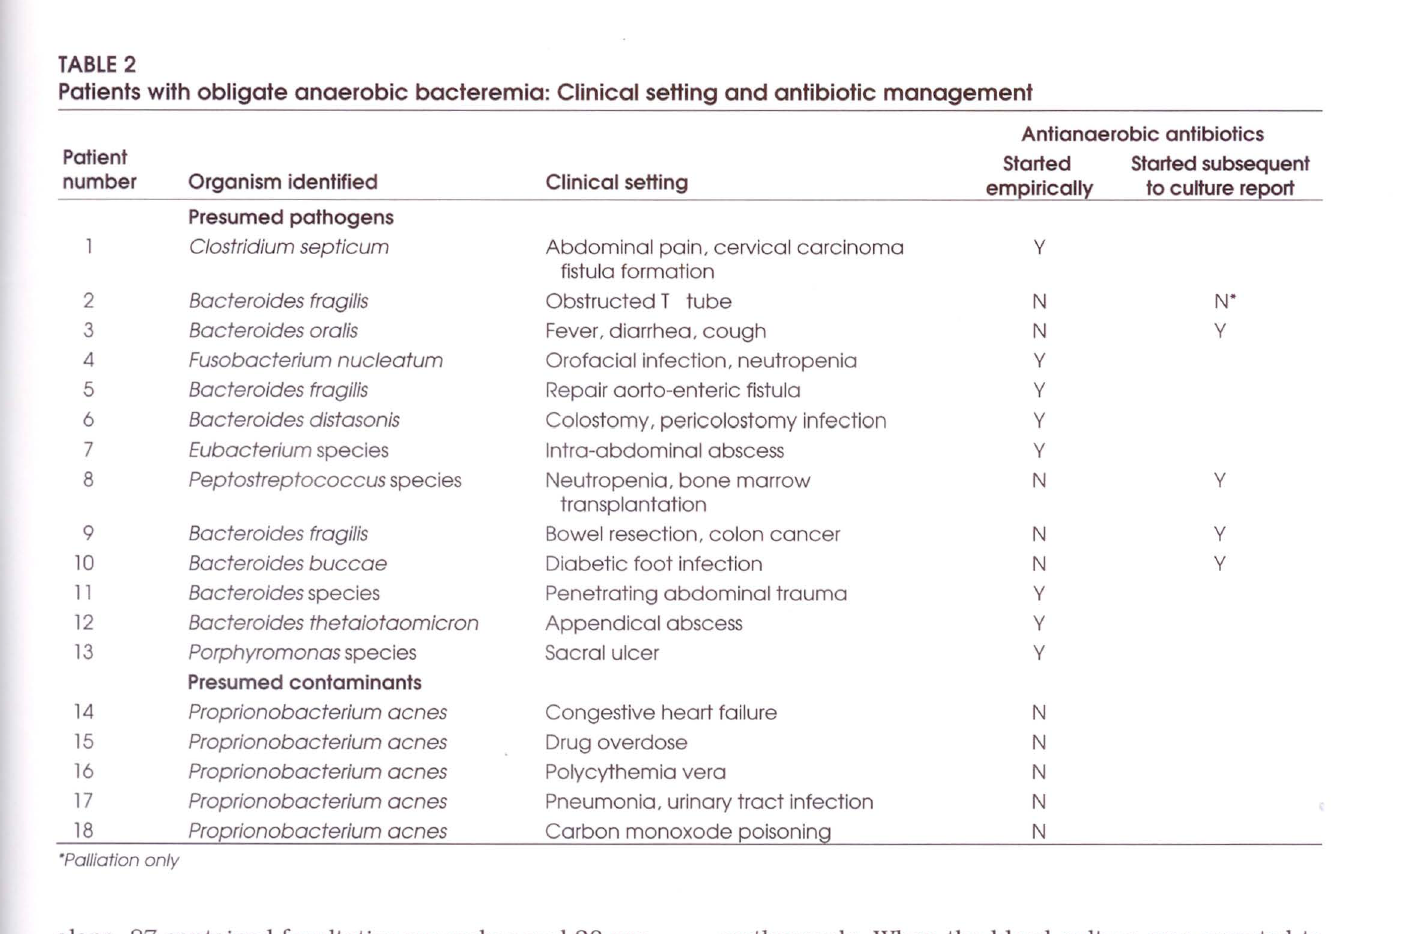
TABLE 2 Patients with obligate anaerobic bacteremia: Clinical setting and antibiotic management Patient number Organism identified Clinical setting